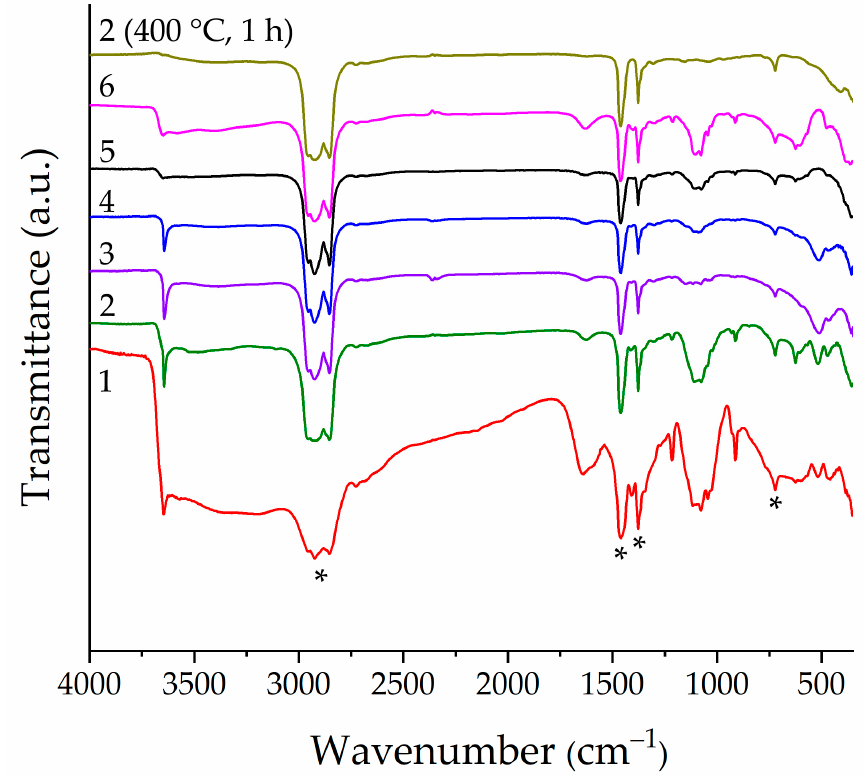
Figure 3. IR spectra of the semi-products (samples 1–6) after drying (100 ◦ C, 3 h) and NiO powder (sample 2, as an example) obtained via additional heat treatment at 400 ◦ C for 1 h; the “*” marker indicates Vaseline oil bands.